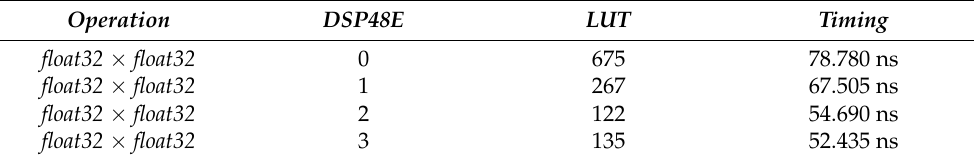
Table 4. Summary of the hardware resources and timing in an FPGA by performing multiplication operations with two floating point